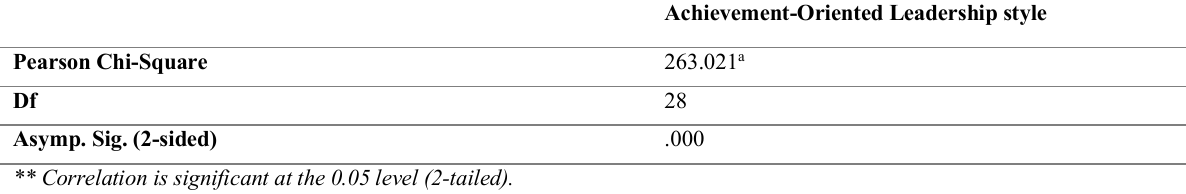
Table 9 : Chi-square test on achievement oriented leadership style